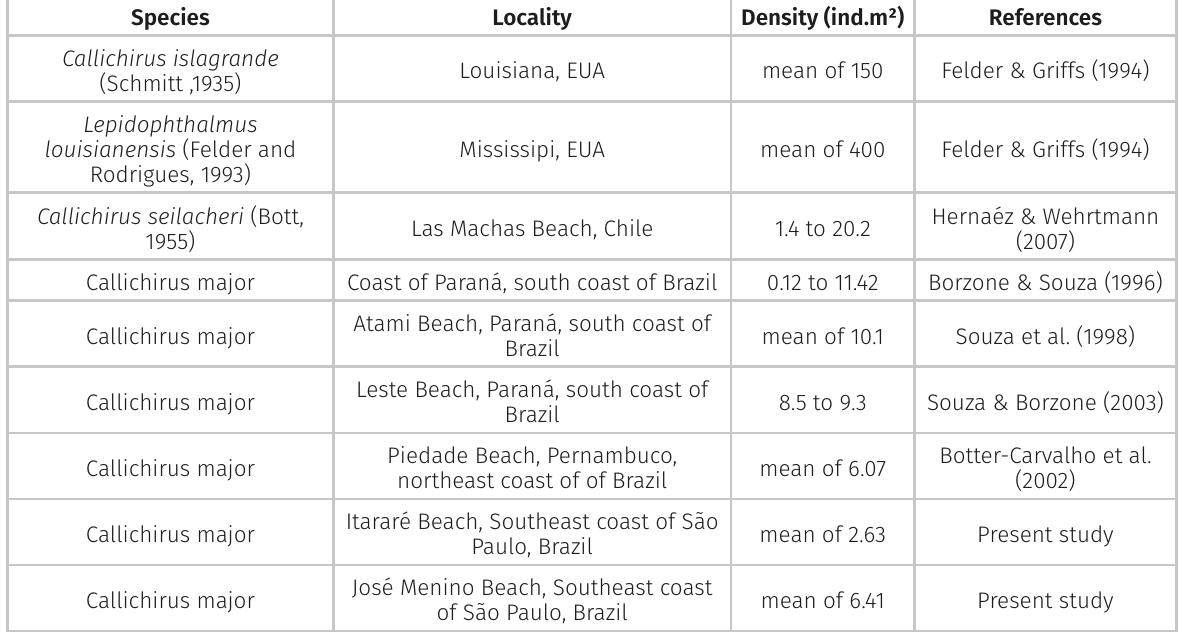
Table II. Densities of callianassids in various localities along the American Coast (Atlantic and Pacific